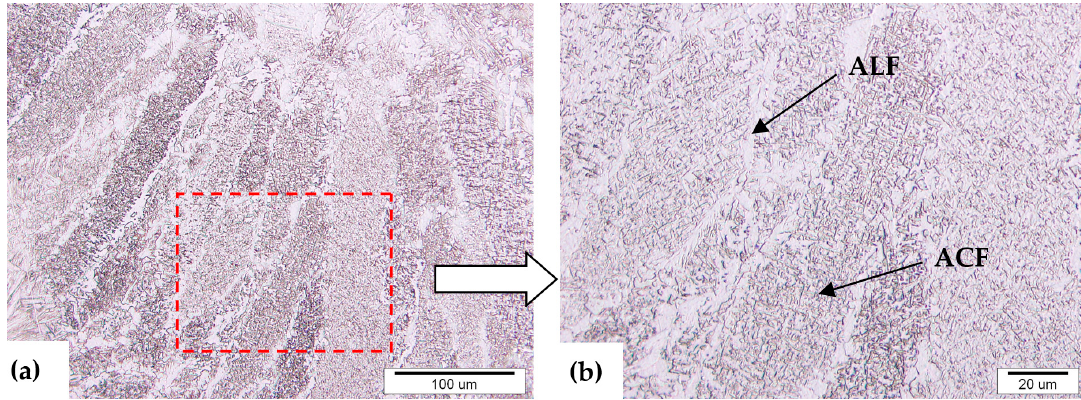
Figure 12. Microstructure ( a ) on the boundaries of HAZ / weld root, and ( b ) magnified view corresponding to the marked region in ( a ).